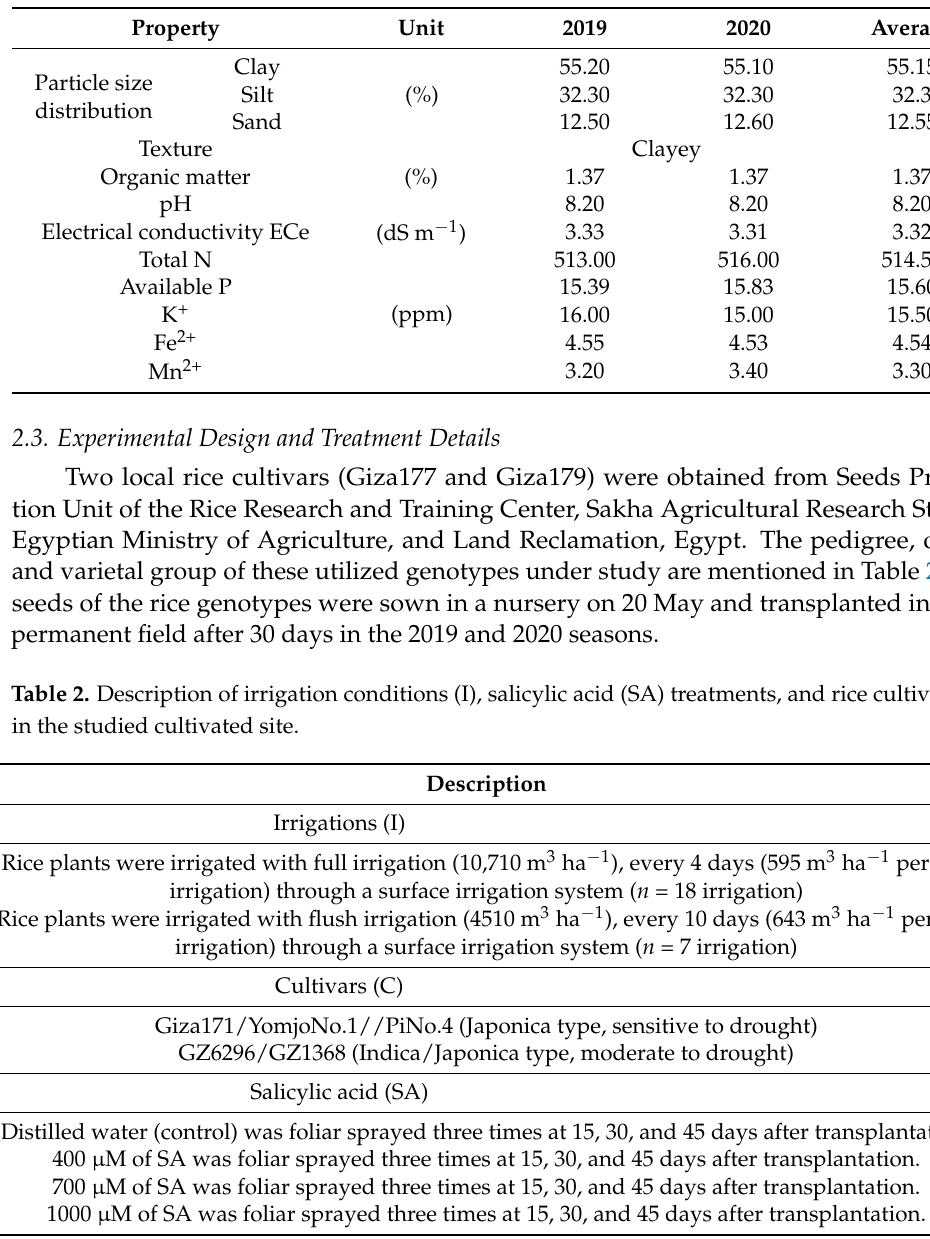
Table 1. Physical and chemical properties of the experiment soil at Sakha Research Station in the 2019 and 2020 years.